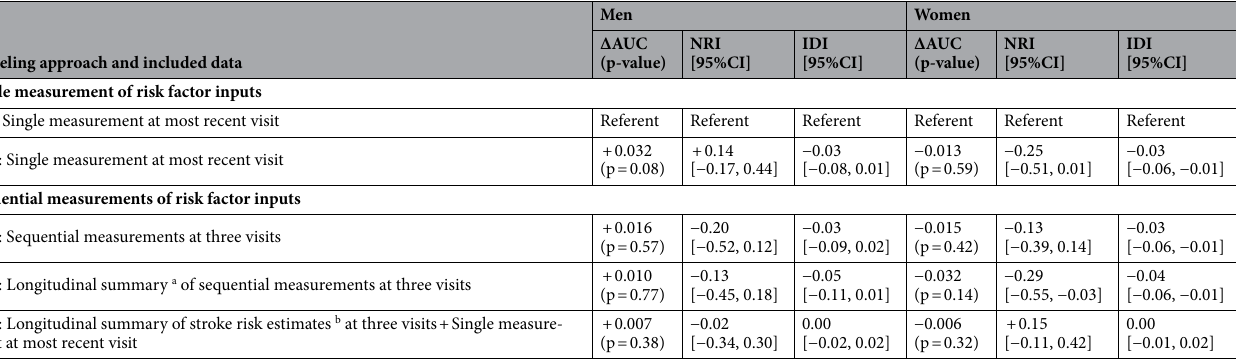
Table 3. Net reclassification index (NRI) and integrated discrimination index (IDI) of Cox and Gradient Boosted Tree (GBT) modeling approaches for predicting 3-year risk of stroke. a Longitudinal summary of risk factor inputs included (i) mean, standard deviation, minimum, and maximum values recorded for continuous risk factor inputs, and (ii) mean and standard deviation for binary risk factor inputs. b Longitudinal